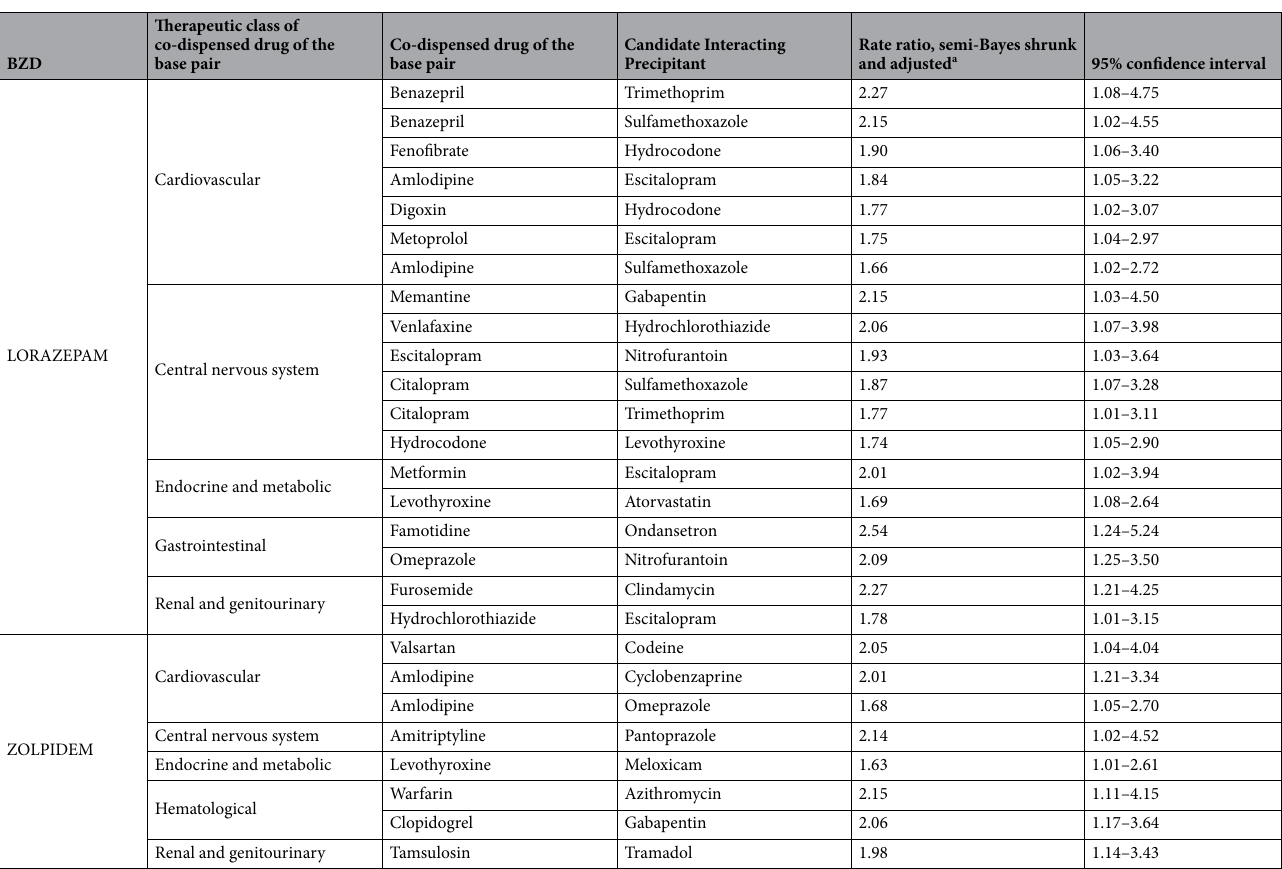
Table 3. Benzodiazepine and related drugs (BZD) drug-drug-drug interaction signals of potential clinical concern given statistically significantly increased rates of unintentional traumatic injury, by commonly used BZD and therapeutic category of co-dispensed drug of the base pair. **p = 0.049. a Rate ratio was calculated as outcome rates during candidate precipitant-exposed person-time divided by outcome rates during candidate rate BZD base pair + candidate precipitant precipitant-unexposed days, i.e., rate BZD base pair , adjusting for the following